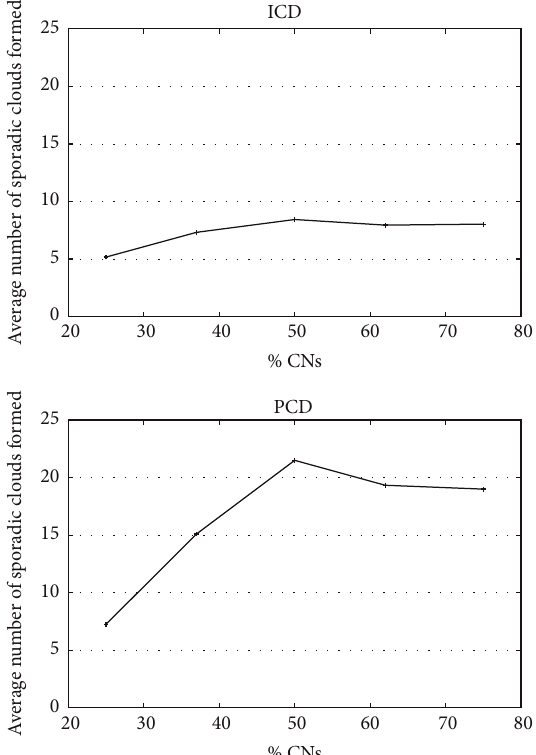
Figure 14: Average number of augmentation sporadic clouds formed in ICD and PCD against different ratios of CNs within the